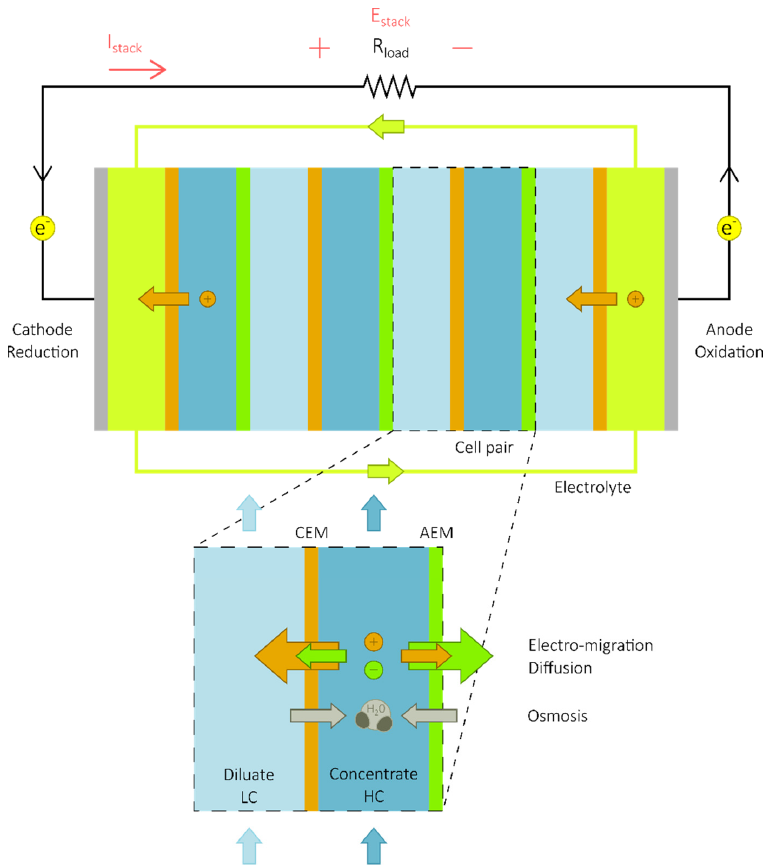
Figure 1. Working principle of reverse electrodialysis (RED).